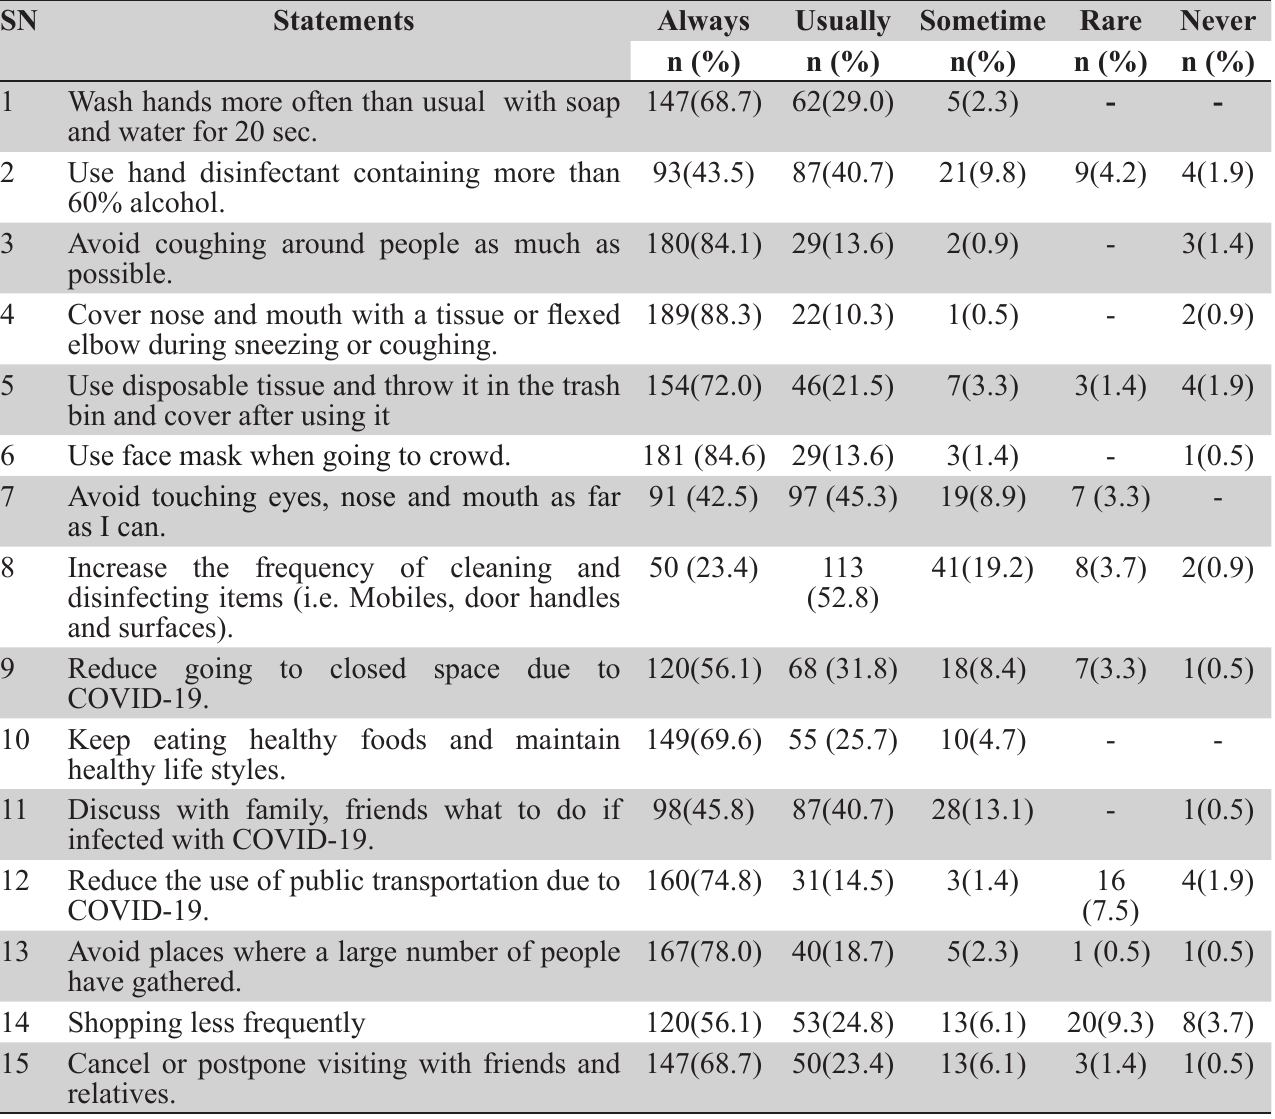
Table 2. Respondents' practice on prevention of COVID-19 (n=214). SN